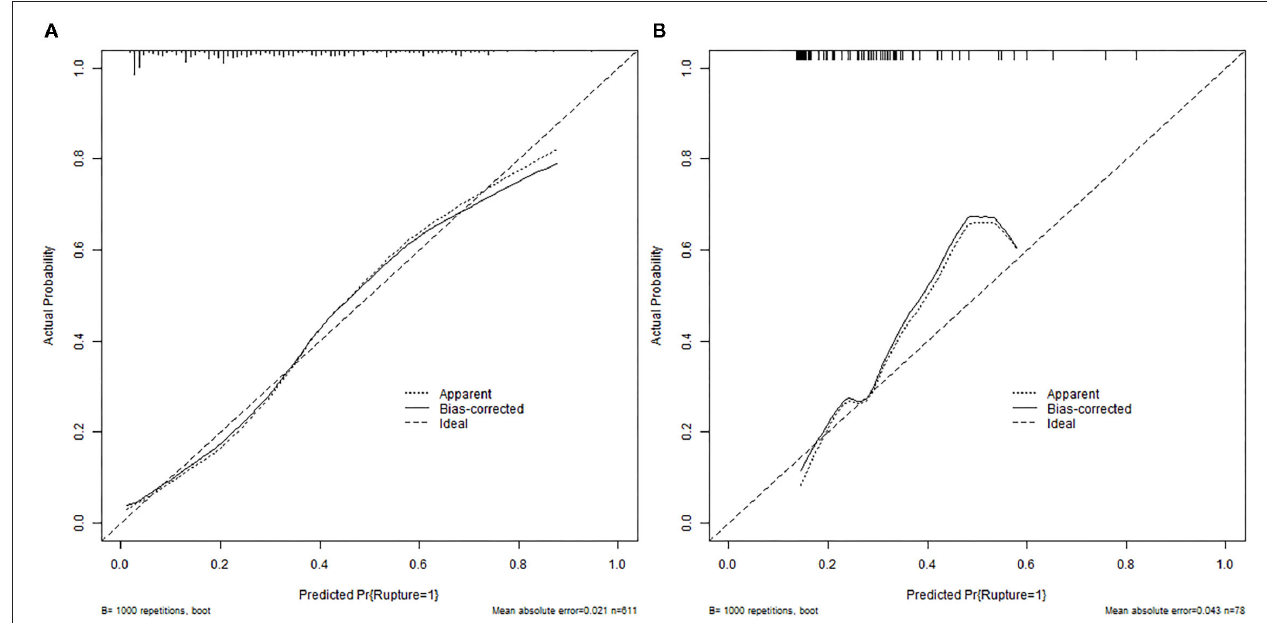
FIGURE 3 | Calibration plots for the nomogram in training (A) and external validation (B) cohorts. The diagonal dashed line represents the ideal plot of the calibration plot. The dotted line represents the performance of the nomogram, while the solid line corrects for any bias in the nomogram.